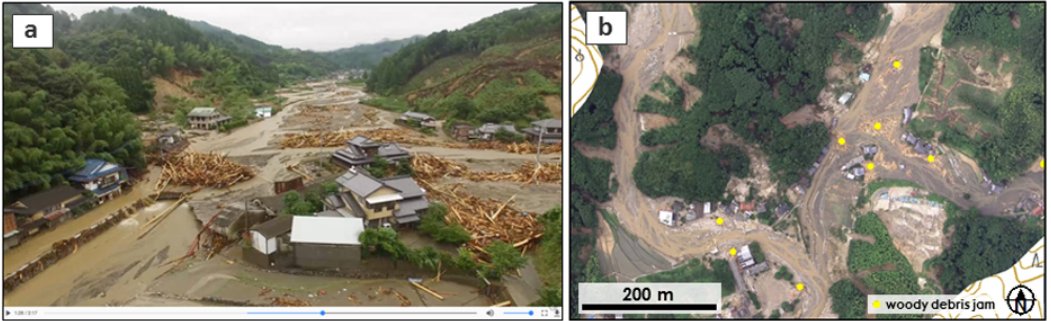
Figure 5. Image captures of a flood hazard using RPASs just after the 2017 heavy rain in northern Kyushu in early July (south-west Japan), provided by GSI. (a) A screenshot of the aerial video of a flooded area along the Akatani River, Asakura city in Fukuoka Prefecture. (b) Orthorectified image of the damaged area. Locations of woody debris jam are mapped and shown on the online map (GSI, 2017). The video and map products are freely provided (compatible with Creative Commons Attribution 4.0